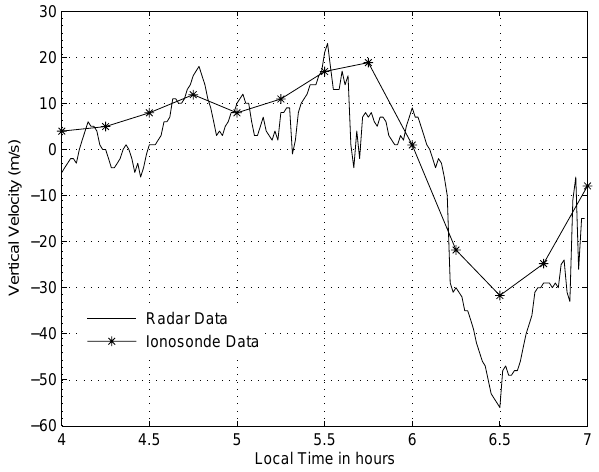
Fig. 1. F-region vertical velocity profile of 23 December 2004, ob- served at 2.5MHz using both HF Doppler radar (one minute reso- lution) and ionosonde (15min resolution). Ground sunrise time –